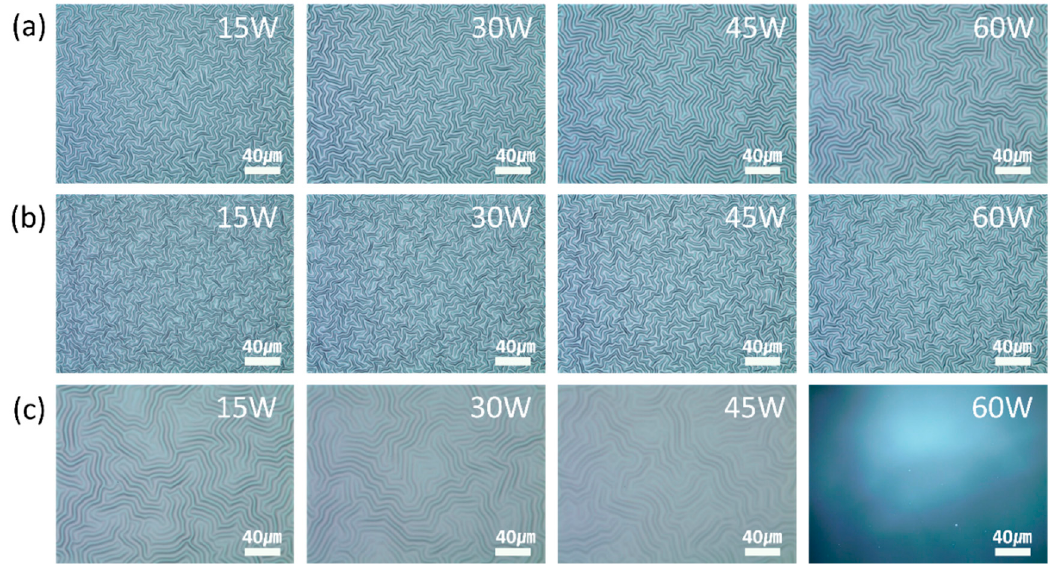
Figure 8. OM images of the various wrinkles generated by ( a ) nitrogen, ( b ) oxygen, and ( c ) argon plasma treatments at different magnitudes of the plasma power.